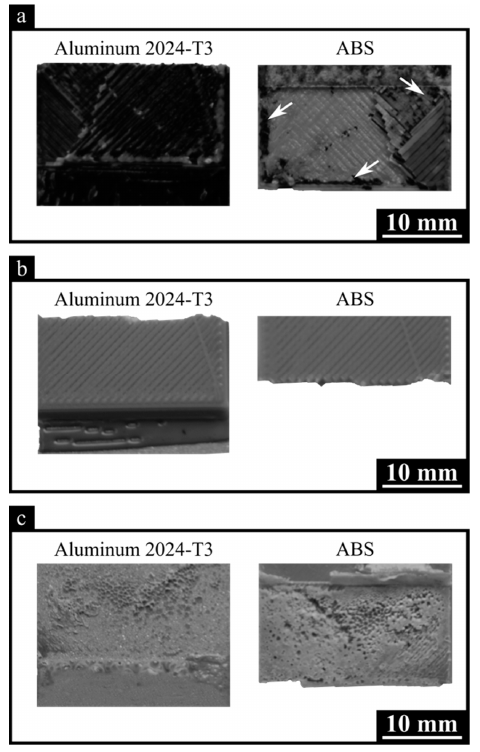
Figure 5. Fracture surface from the mechanically tested AddJoining hybrid joints for ( a ) process variant one (with adhesive), ( b ) variant two (with heating control) and ( c ) variant three (with thin- coating layer). Figures show the whole overlap area of hybrid joints after mechanical testing. The direction of the load application during lap-shear testing is aligned from the bottom to the top of the figures.